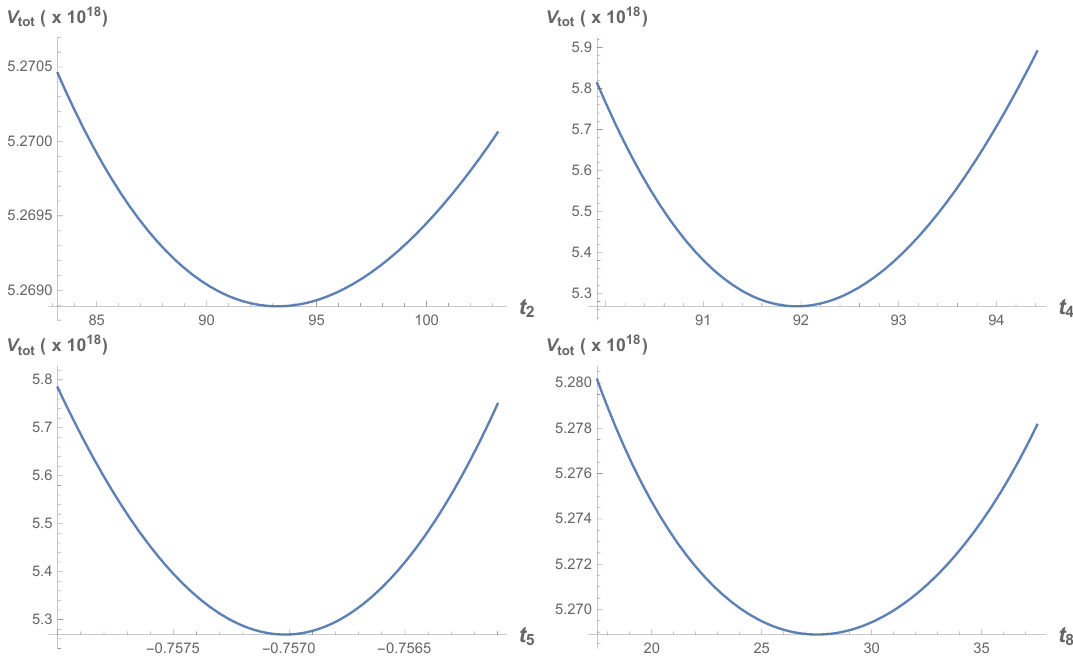
Figure 1 . Plots of the total scalar potential (5.9) along the four directions corresponding to the 4 volume moduli t i